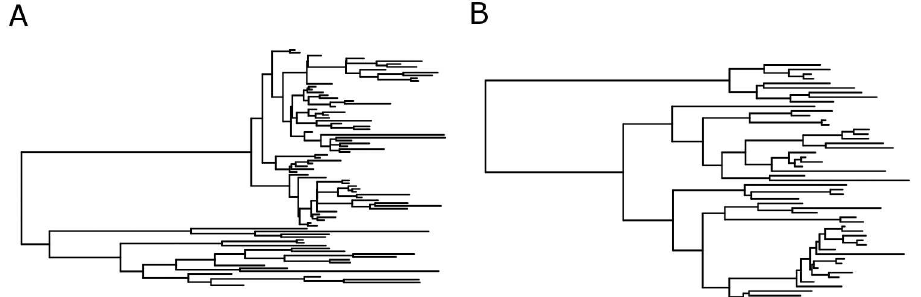
Fig 8. Time-scaled HIV-1 phylogenies from the Swedish epidemic among IDU. A. The genealogy from a rapid CRF01 outbreak, and B the genealogy from a slower spreading subtype B epidemics. Trees were inferred by a Bayesianskyline coalescentmodel using BEAST 1.8 [49].